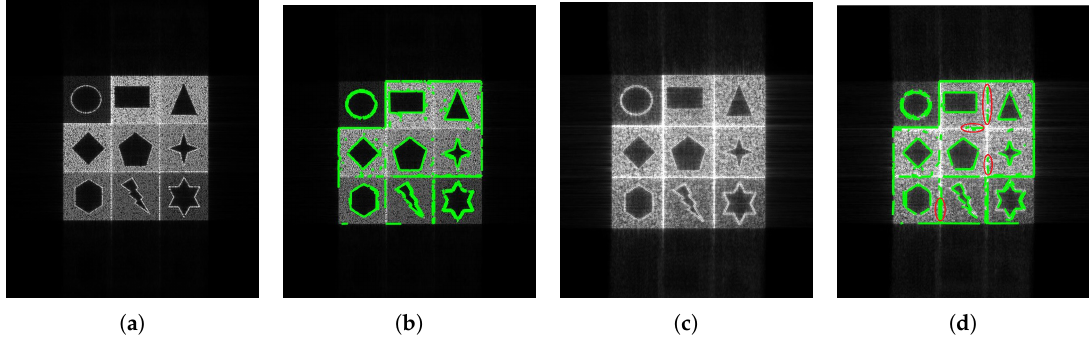
Figure 7. The imaging and edge detection result of complex graphics area. ( a ) Original image; ( b ) edge detection result of the original image; ( c ) edge-enhanced SAR image; ( d ) edge detection result of the edge-enhanced SAR